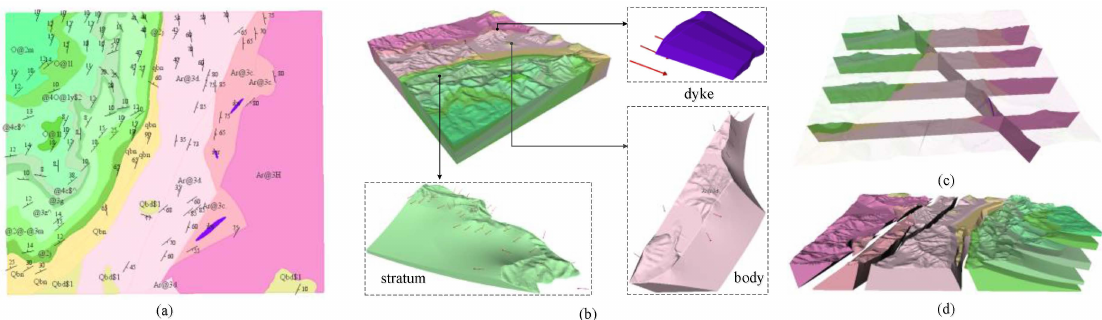
Figure 12. Realistic geological model: ( a ) 2D geological map of the study area; ( b ) 3D geological model, the three main parts of the model and the constraining attitudes’ displayed as arrows; ( c ) cross-sections of the geological model; and ( d ) exploded view of the models.